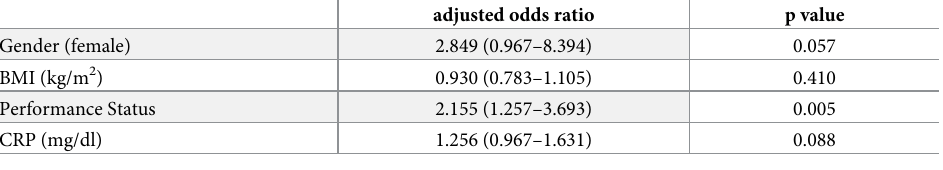
Table 4. Multivariate logistic regression analysis of baseline characteristics associated with non-upper predomi- nant lung